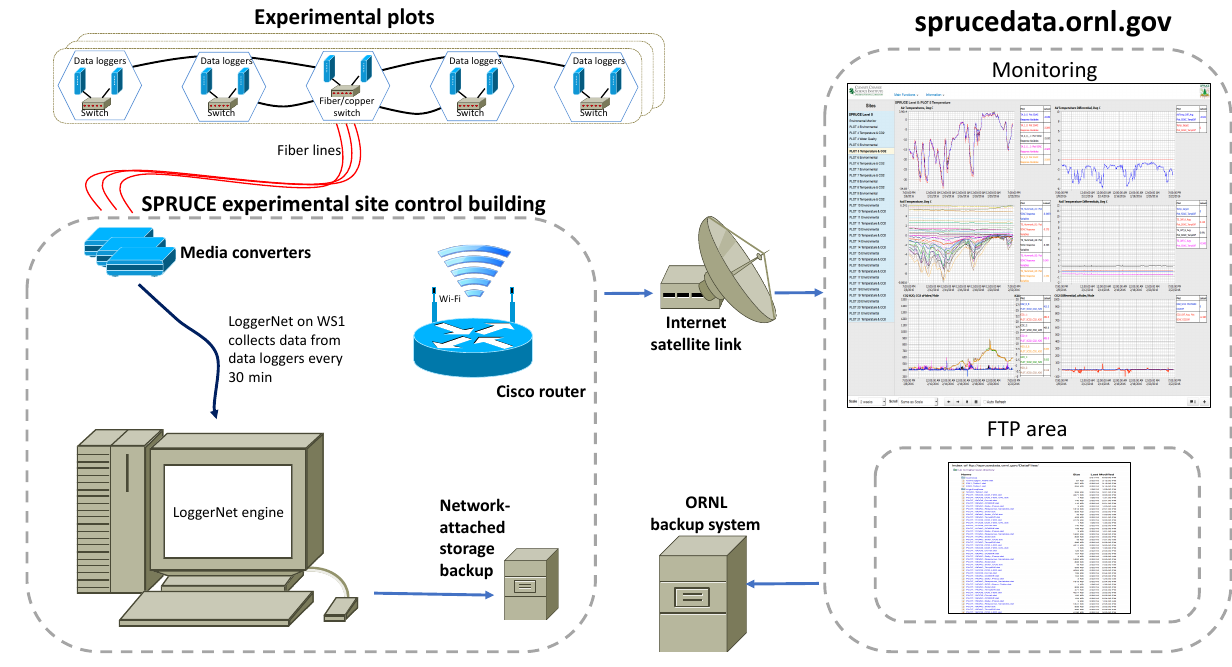
Figure 2. SPRUCE data